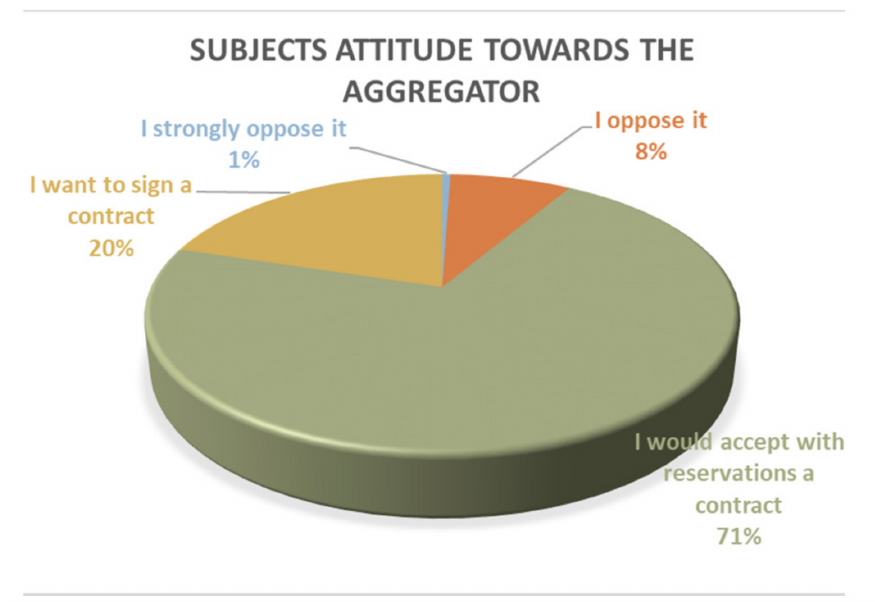
Figure 9. Consumers attitude toward the aggregator. Source: Authors’ own